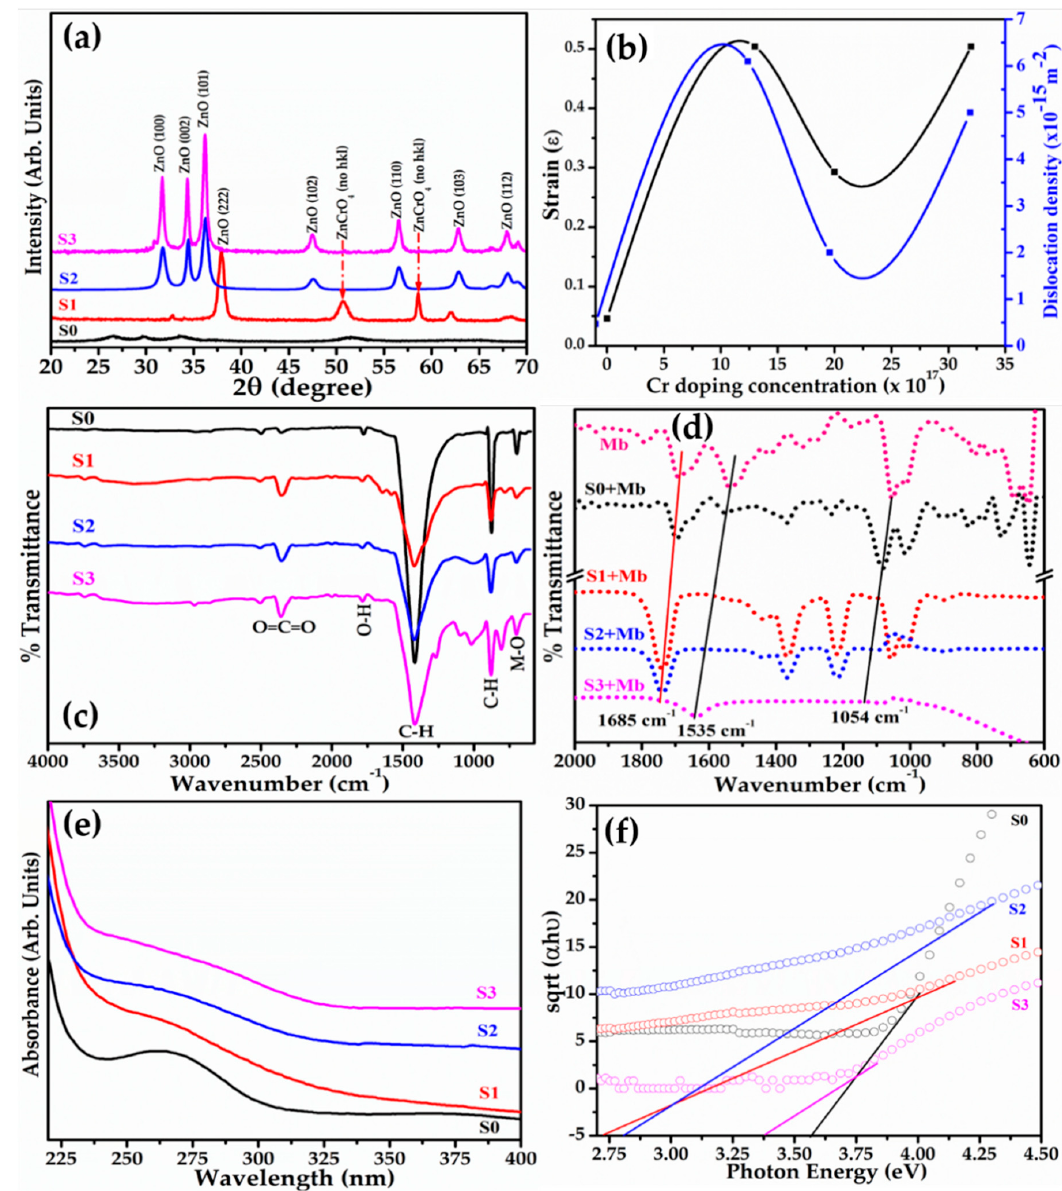
Figure 2. Typical ( a ) X-ray diffraction pattern; ( b ) strain and dislocation density; ( c ) Fourier transform-IR spectra; ( d ) FTIR spectra of synthesized NPs titrated with Mb; ( e ) set of UV–Vis absorption spectra; and ( f ) Tauc’s plot of synthesized pure ZnO and Cr-doped ZnO NPs. Figure 3 represents the X-ray photoelectron (XPS) spectra of Zn-2p, Cr-2p, and Table 1. Crystal and optical characteristics of the synthesized pure and Cr-doped ZnO O-1s core-level states of pure and Cr-doped ZnO NPs. Figure 3a reveals the peak of Zn-2p 3/2 and Zn-2p 1/2 states at a binding energy (B.E.) of 1021.5 eV and 1044.0 eV, respectively, for pristine ZnO can be correlated with the oxygen-bound Zn ions in the system. The value of the B.E. is on the lower side compared to that of ZnO ions in the bulk system, which is 1022.5 eV and 1045.0 eV, respectively [54]. The peaks of Zn- 2p3/2 and Zn-2p1/2 in the Cr-doped sample are shifted towards low energy by about 0.049 eV suggesting oxygen-deficient NPs. A kink in the Zn-2p 3/2 peak shown by